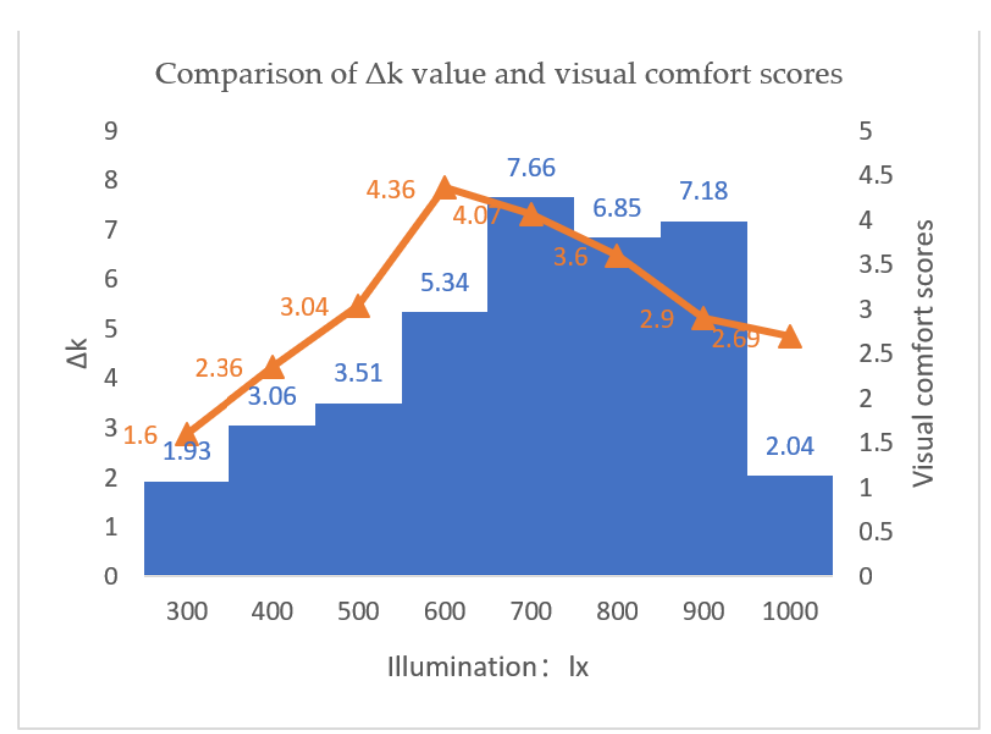
Figure 12. Comparison diagram of ∆ k and visual comfort scores. Table 10. Ranking of scores of the visual comfort